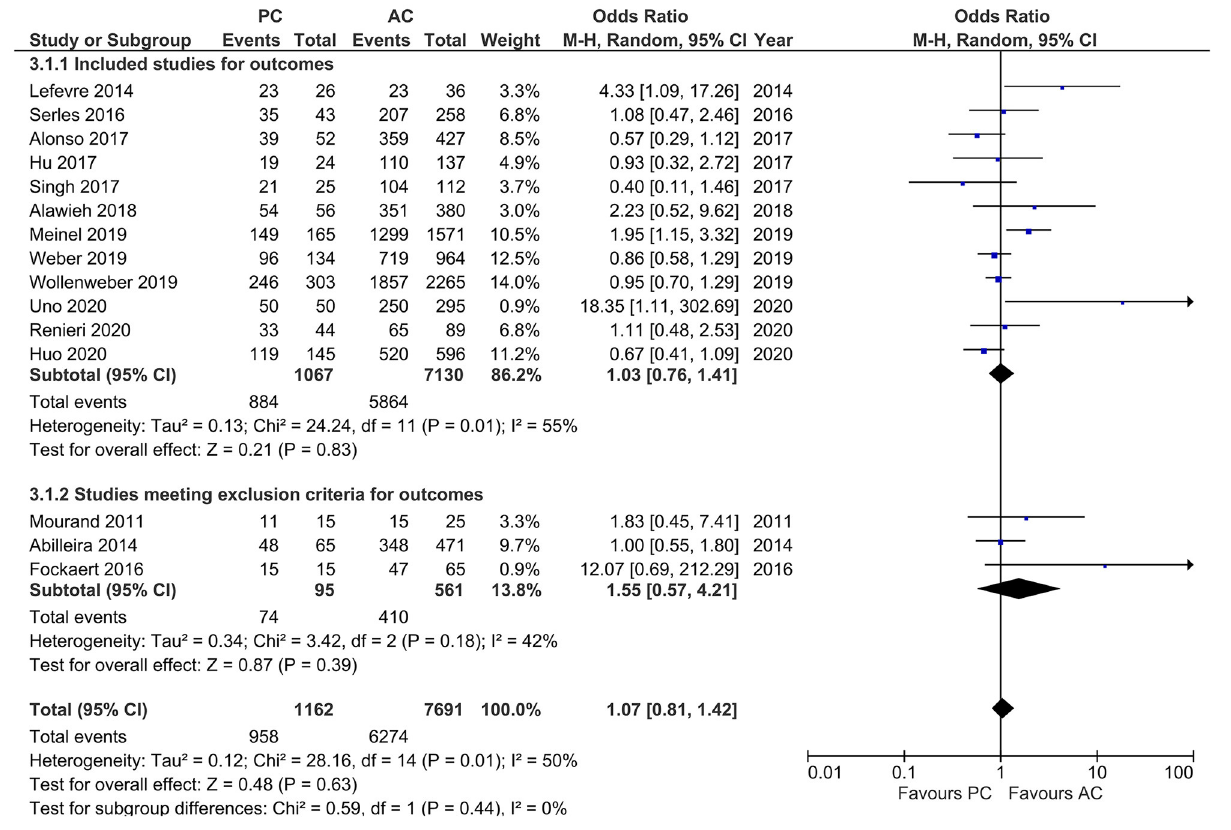
FIGURE 8 | Forest plot of main and subgroup analyses comparing “successful recanalization” defined as thrombolysis in cerebral infarction scale (TICI) 2/3 in patients with large vessel occlusion (LVO) in the posterior circulation (PC) vs. anterior circulation (AC) who were treated with endovascular mechanical thrombectomy. Three studies with < 20 PCLVO patients and/or patient recruitment primarily until 2012 were excluded from subgroup analysis. Chi 2 , chi-square statistic; CI, confidence interval; df, degrees of freedom; I 2 , I -square heterogeneity statistic; M-H, Mantel–Haenszel statistic; P , p -value; Tau 2 , estimated variance of underlying effects across studies; Z , Z